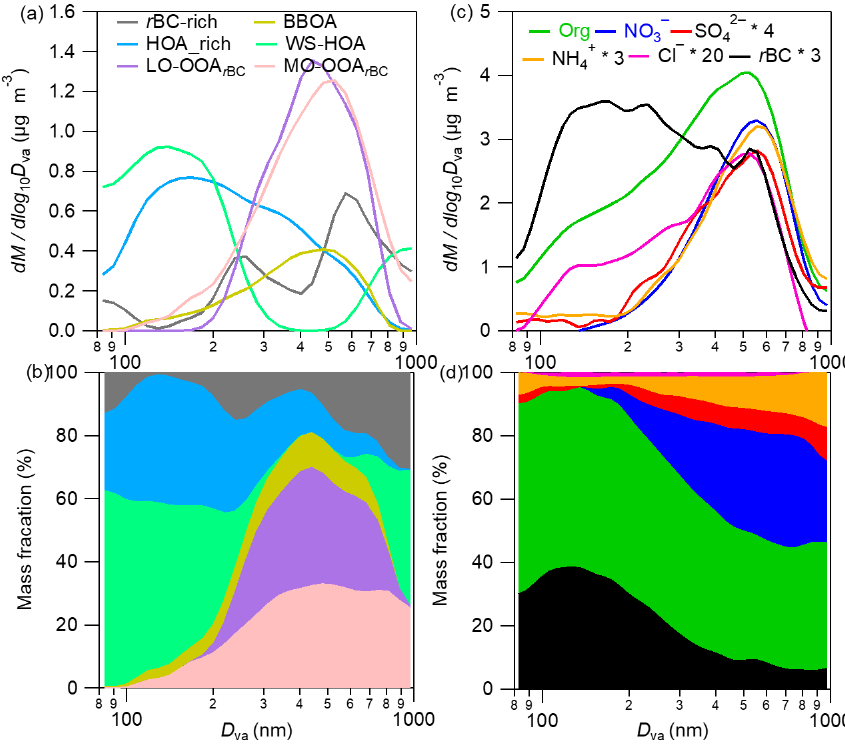
Figure 4. Campaign-average size distributions of the six rBCc-particle OA factors (a) and individual rBCc-particle components (b) , corre- sponding mass contributions of the six factors to the total rBCc-particle OA (c) and the major components of the total rBCc particles (d) at different sizes (80–1000nm).